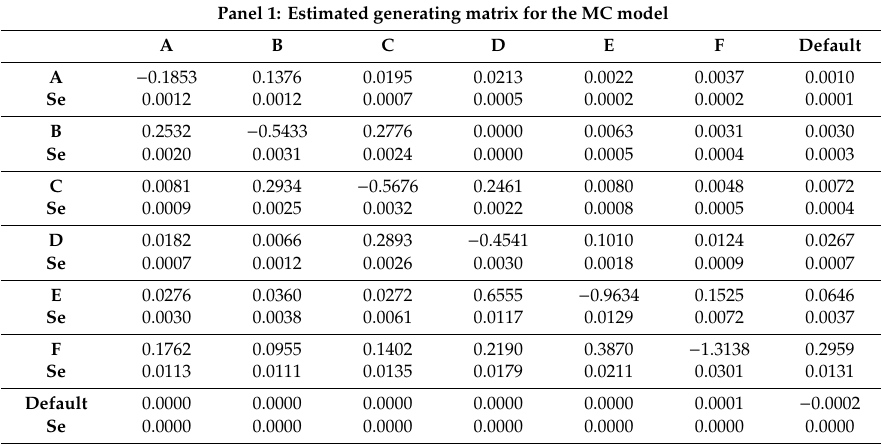
Table 3. Estimated generating matrix for the Markov Chain (MC) model (panel 1) and estimated generating matrix and probability to be a ‘Stayer’ for the Mover-Stayer (MS) model (panel 2). Panel 1 shows the estimated generating matrix for the Markov Chain model. Panel 2 shows the estimated generating matrix and the probability to be a ‘Stayer’ according to the Movers-Stayers model. Panel 1: Estimated generating matrix for the MC